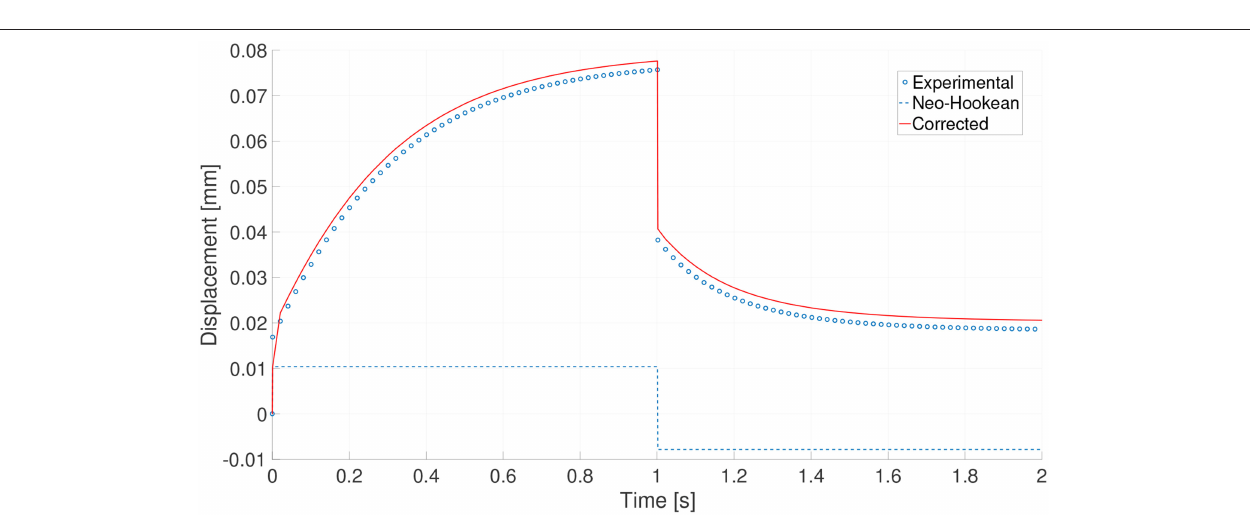
Frontiers in Materials |